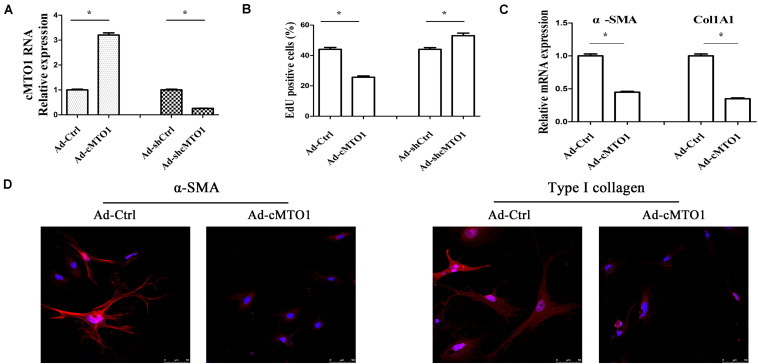
Effects of cMTO1 on HSC activation. Primary 1-day-old HSCs were transduced with Ad-cMTO1 or Ad-shcMTO1 for 48 h. (A) cMTO1 expression. (B) HSC proliferation. (C) The mRNA expression levels of α-SMA and Col1A1. (D) Immunofluorescence staining for α-SMA (red) and type I collagen (red) was analyzed in cMTO1-over-expressing HSCs by confocal laser microscopy. DAPI stained nuclei blue. Scale bar = 50 μm for 400×. *P < 0.05. Each value is the mean ± SD of three experiments.